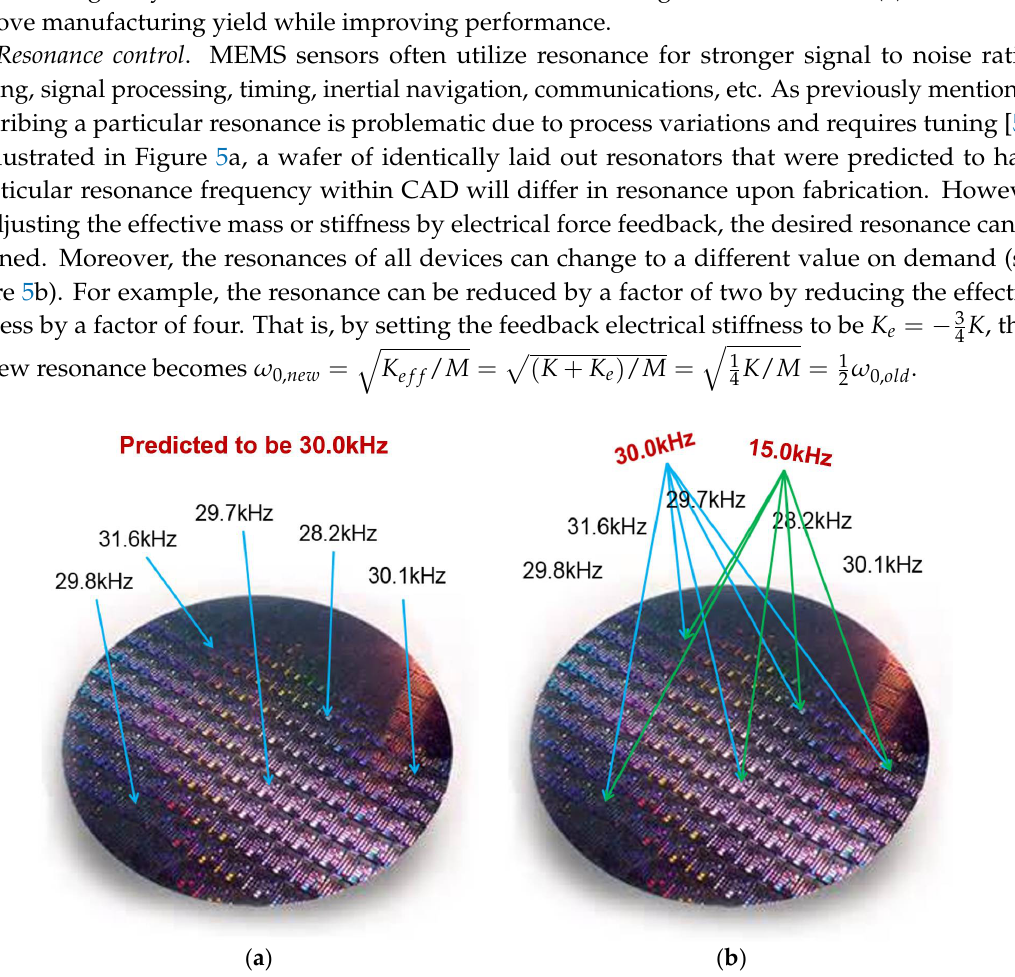
Figure 5. An illustration of PODMEMS resonance control for a multitude of resonators that were initially designed to resonate at 30.0 kHz. ( a ) Due to process variations, none of the MEMS devices will naturally resonate at 30.0 kHz. ( b ) By activating PODMEMS performance control, all devices will be able to identically resonate at 30.0 kHz, or change resonance on demand to a different frequency, such as 15.0 kHz.